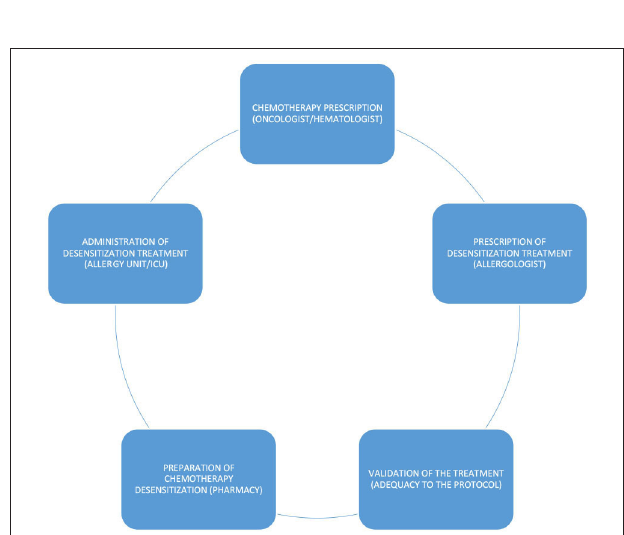
FIGURE 4 | Desensitization treatments